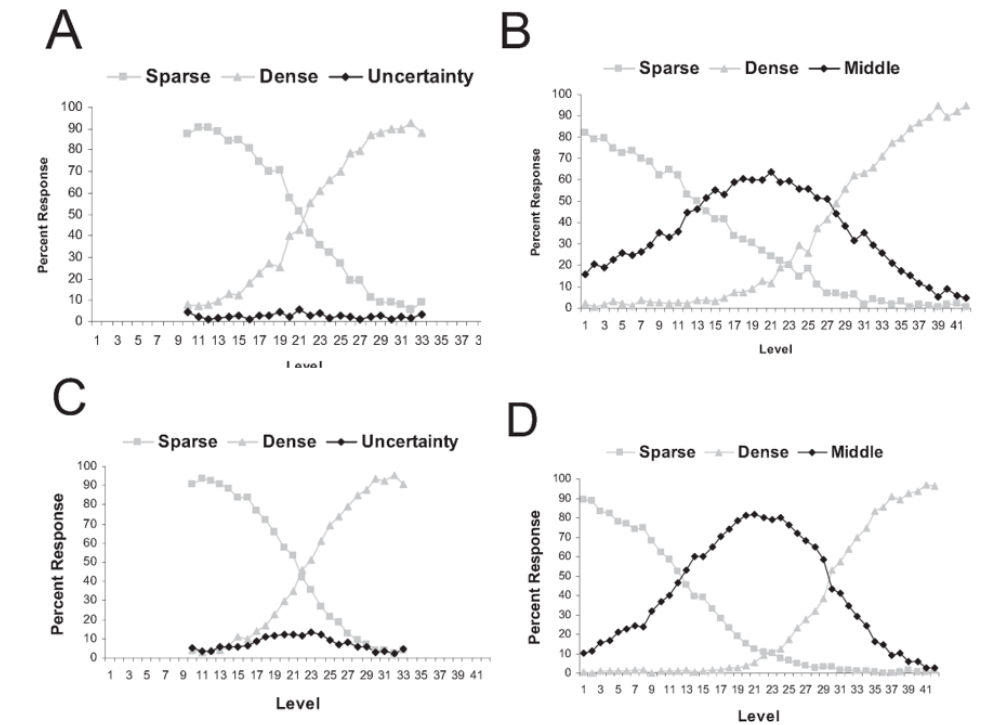
Figure 4 . Performance in Experiment 2 of Beran et al. (2009) by task order completion. The top row shows performance for monkeys who completed the SUD task ( A ) followed by the SMD task ( B ). The bottom row shows performance for monkeys who completed the SMD task ( C ) followed by the SUD task ( D ). From “The Psychological Organization of “Uncertainty” Responses and “Middle” Responses: A Dissociation in Capuchin Monkeys ( Cebus apella ),” by M. J. Beran, J. D. Smith, M. V. C. Coutinho, J. J. Couchman, and J Boomer, 2009, Journal of Experimental Psychology: Animal Behavior Processes, 35 , p. 377. Copyright 2009 by the American Psychological Association. Reprinted with